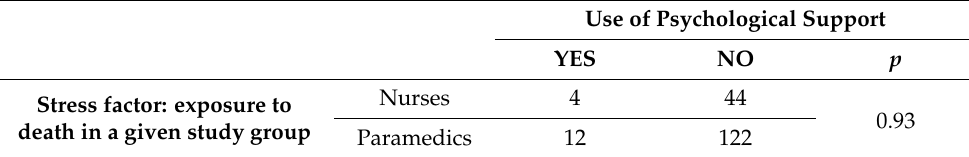
Table 12. The correlation between the use of psychological help and dealing with death. Use of Psychological Support YES NO p Nurses 4 44 Stress factor: exposure to 0.93 death in a given study group Paramedics 12